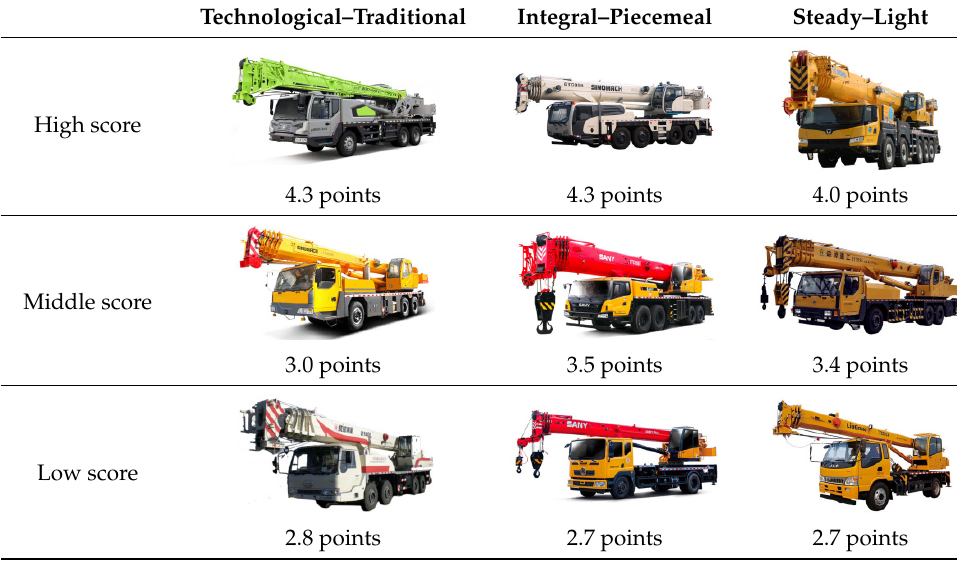
Figure 5. Proce dure s and results of the eye-movement experiment.